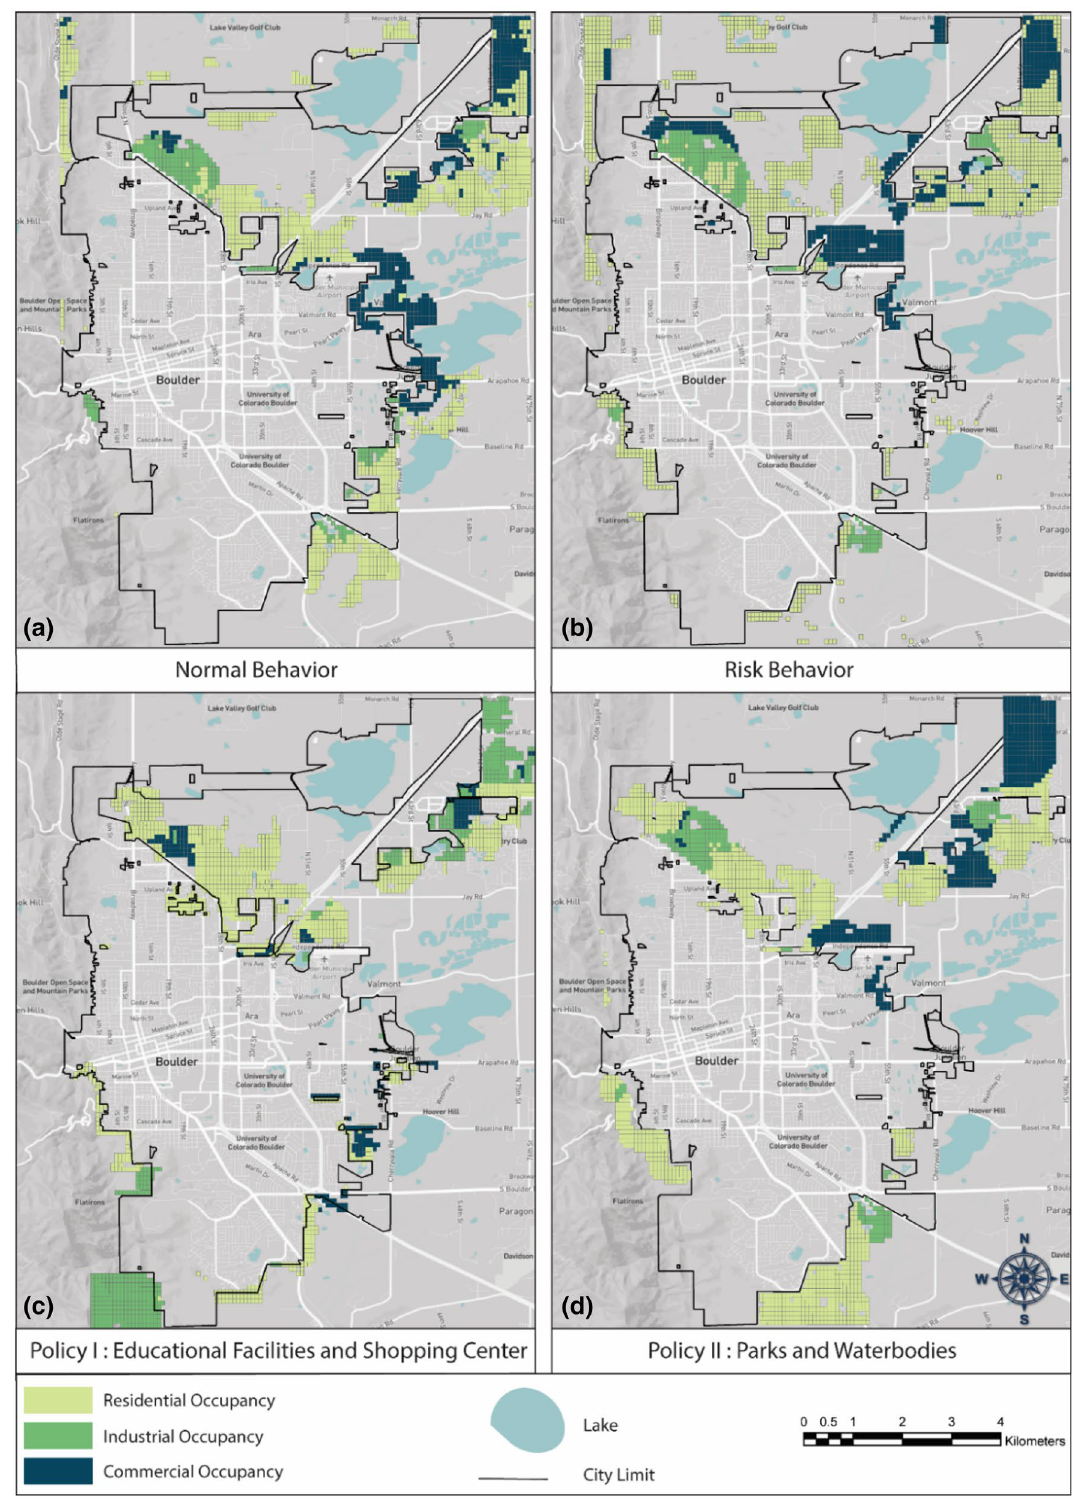
Figure 7. Growth projections for the City of Boulder, considering developer’s: ( a ) Normal Behavior, ( b ) Risk- informed Behavior, ( c ) Policy I, and ( d ) Policy II—figures created using Python 3.9.5 (https:// www. python. org/